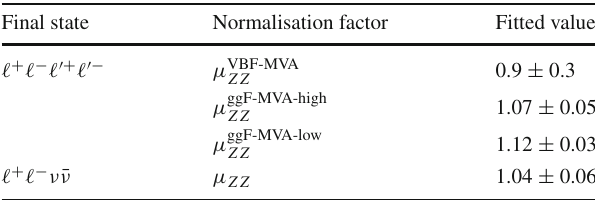
Table 2 The Z Z normalisation factors together with their total (statis- tical+systematic) uncertainties in each category of the two final states, which scale the number of Z Z events estimated from the simulations, obtained from a simultaneous likelihood fit of the two final states under the background-only hypothesis. For the (cid:3) + (cid:3) − (cid:3) (cid:2)+ (cid:3) (cid:2)− final state,